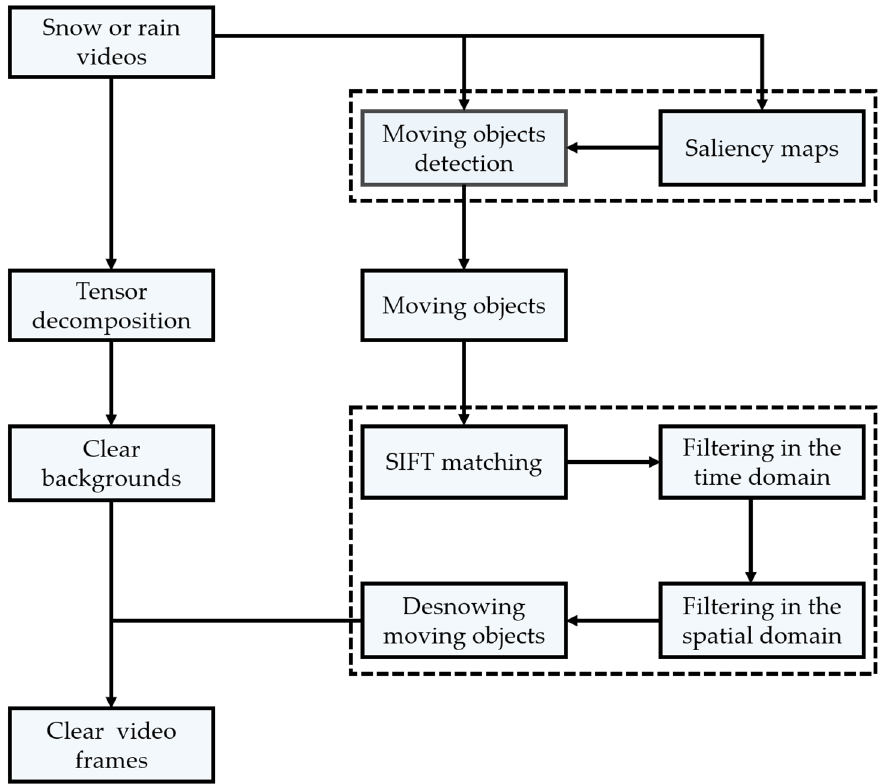
Figure 1. The flow diagram of our proposed algorithm.